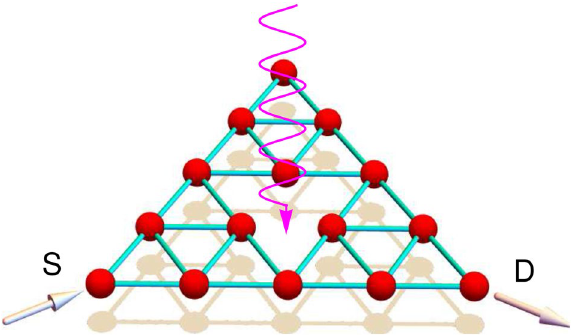
Figure 1. Schematic view of an irradiated 3rd generation SPG fractal network. The atomic sites are located at the vertices of each equilateral triangle, as shown by red solid spheres. The SPG is attached to two electrodes (source S and drain D ). The electrodes are kept at two different temperatures T (cid:31) T is infinitesimally